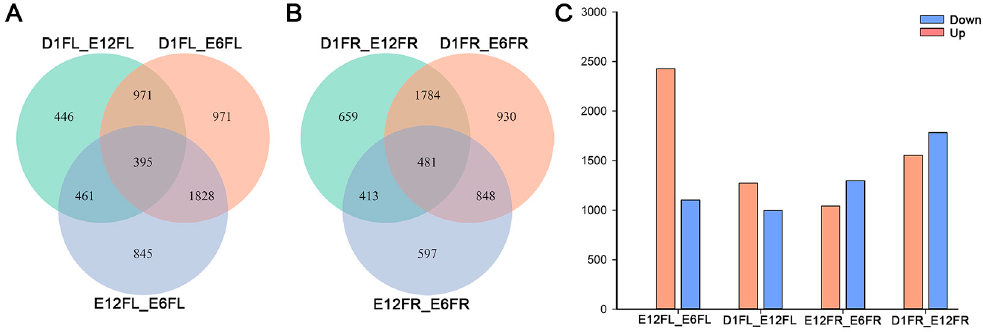
Figure 6. Differential gene expression in the pairwise comparison of developmental stages. Venn diagrams indicate overlap of all DEGs obtained from each pairwise comparison between developmental stages in the left gonad ( A ) and right gonad ( B ). ( C ) Number of DEGs between developmental stages in the female gonads. E12FL_E6FL, E12FL vs. E6FL; D1FL_E12FL, D1FL vs. E12FL; D1FL_E6FL, D1FL vs. E6FL; E12FR_E6FR, E12FR vs. E6FR; D1FR_E12FR, D1FR vs. E12FR; D1FR_E6FR, D1FR vs. E6FR.